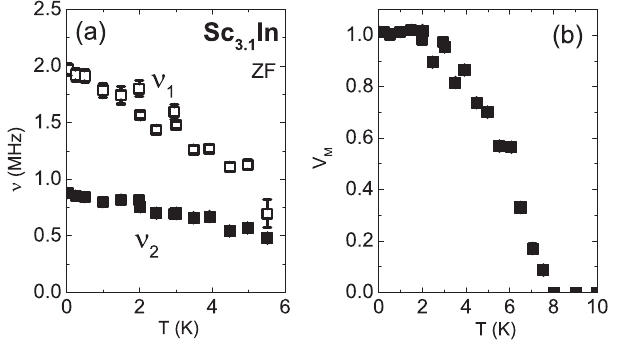
11. (a) The muon-spin precession frequencies ν 1 (full squares) and ν 2 (open squares), and (b) the volume fraction V of the magnetically ordered regions, obtained from ZF μ SR M of Sc 3 . 1